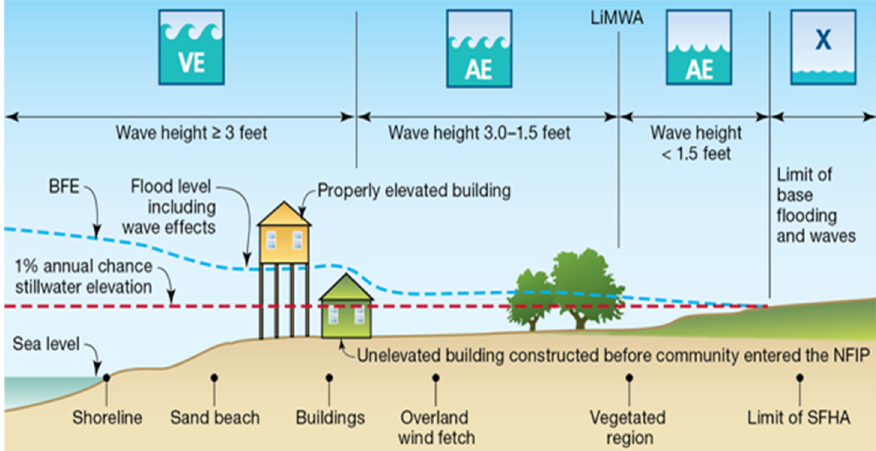
Figure 4. ACOE NACCS [5] structure damage curves for inundation for Prototypes 5A, 6B, and 7A. Minimum, most likely, and maximum curves are provided for each. All plots are percent damage vs. elevation relative to FFE. FEMA definition schematic (lower panel) for flooding and structures located on grade and elevated. The still water elevation (SWEL) for 1% annual chance (100 year) is shown in the dashed red line and the Base Flood Elevation (BFE) in the blue dotted line.